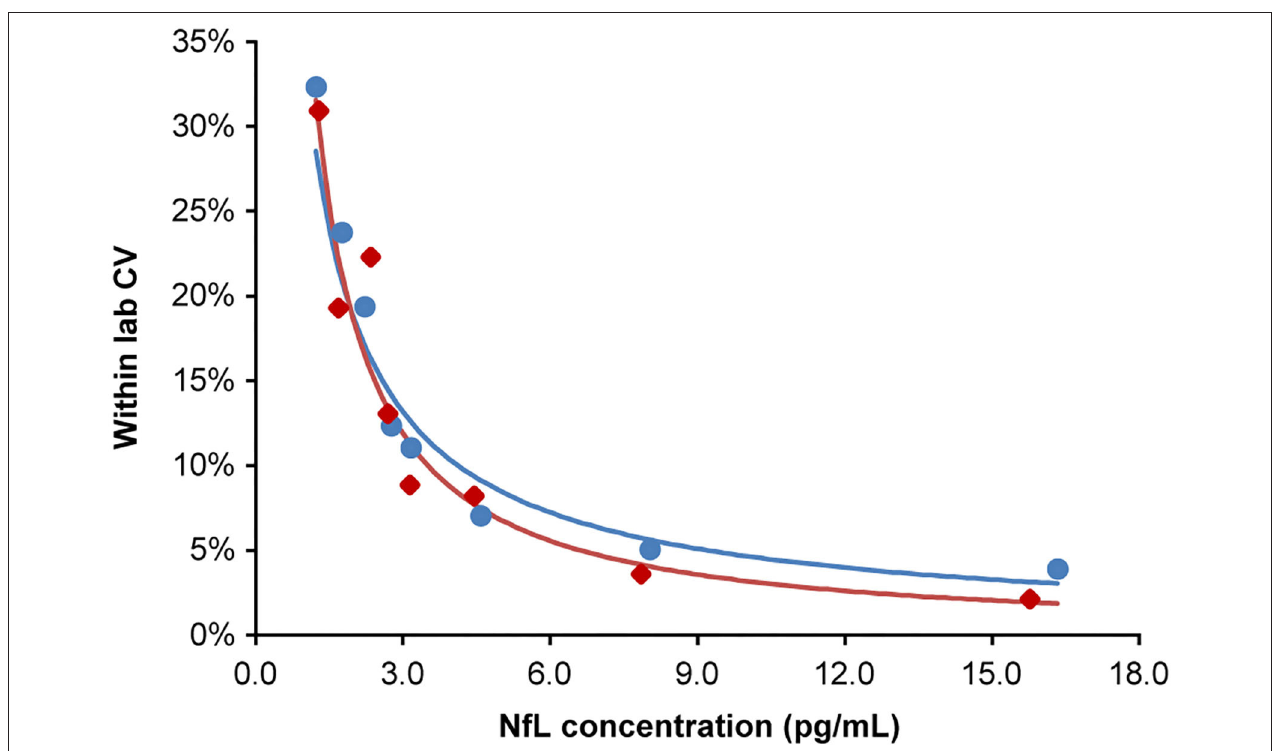
FIGURE 2 | Lower limit of quantitation. Analytical samples at eight concentrations spanning the assay LoB (0.89 pg/mL) to 15-fold above the LoB. Samples generated from donor serum with endogenous NfL diluted in pooled donor serum first depleted of NfL by antibody immunoabsorption. Inter-run, inter-day, and inter-lot variations were tested (four replicates per sample; two runs per day over 5 days; two reagent lots). The lower limit of quantitation for lots 1 and 2 were 1.84 and 1.85 pg/mL, respectively, at a precision cut-off of 20% CV. The blue and red regression lines correspond to lots 1 and 2, respectively. CV, coefficient of variation; LoB, limit of blank; NfL, neurofilament light